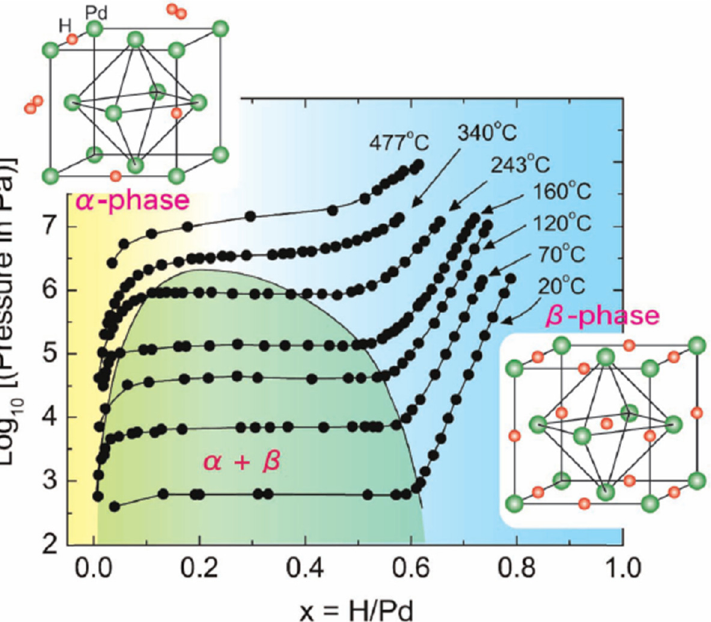
Figure 2. H 2 pressure–composition–temperature (P–C–T) phase diagram of the Pd-H system [22,23]. Copyright (2019), with permission from Chemistry Europe.